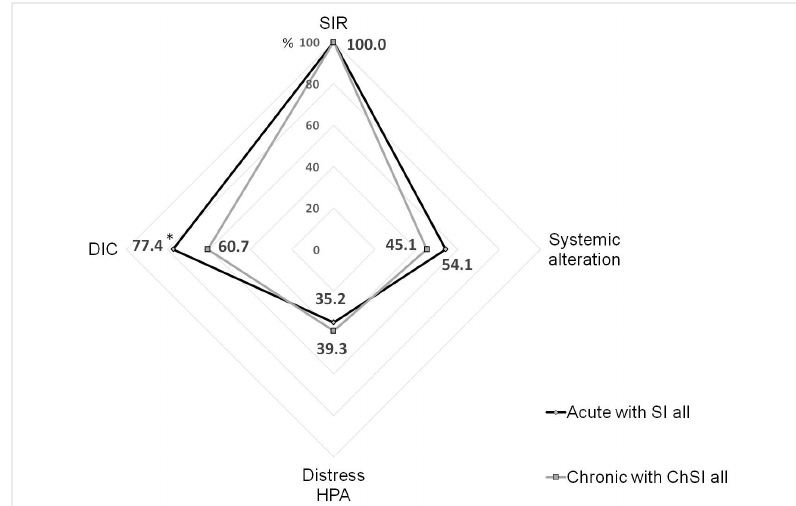
Figure 5. Rate of false positive values by the SI scale in chronic diseases (%).